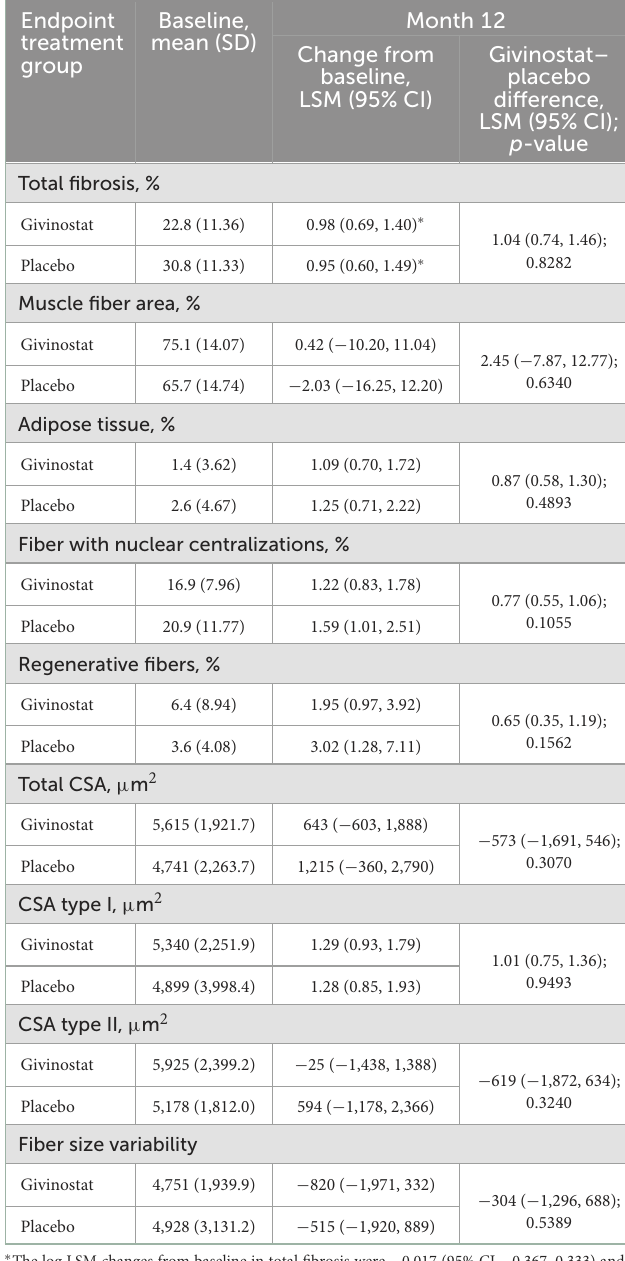
TABLE 2 Histology parameters at baseline and Month